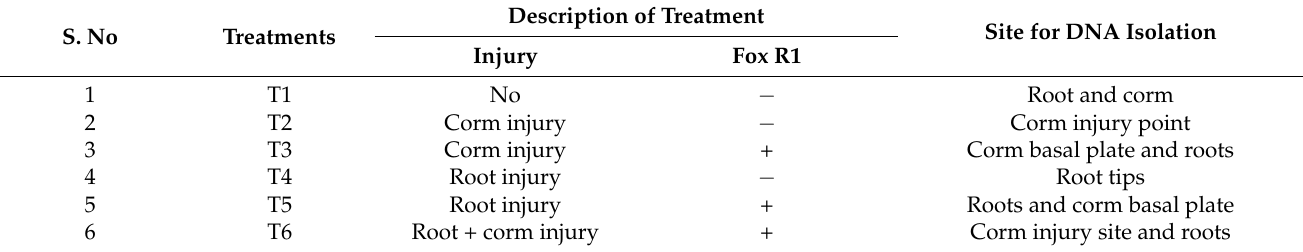
Table 1. Experimental layout for checking the Fusarium oxysporum R1 load in the infected saffron